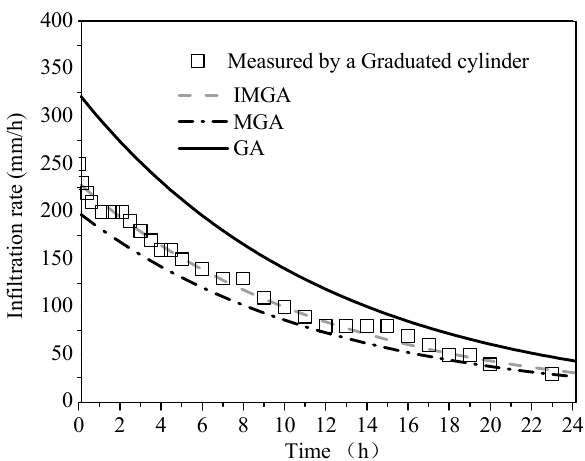
Figure 9. Water infiltration rates estimated by the IMGA, MGA, and GA models.